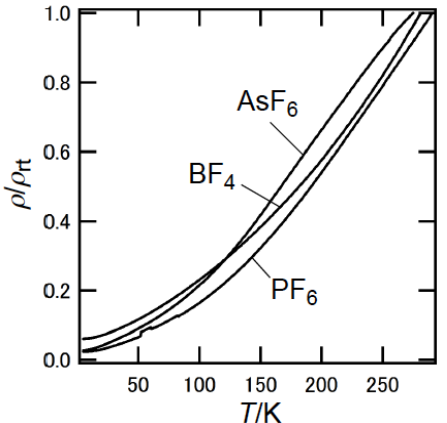
Figure 26. Temperature dependence of the resitivities for the AsF meso